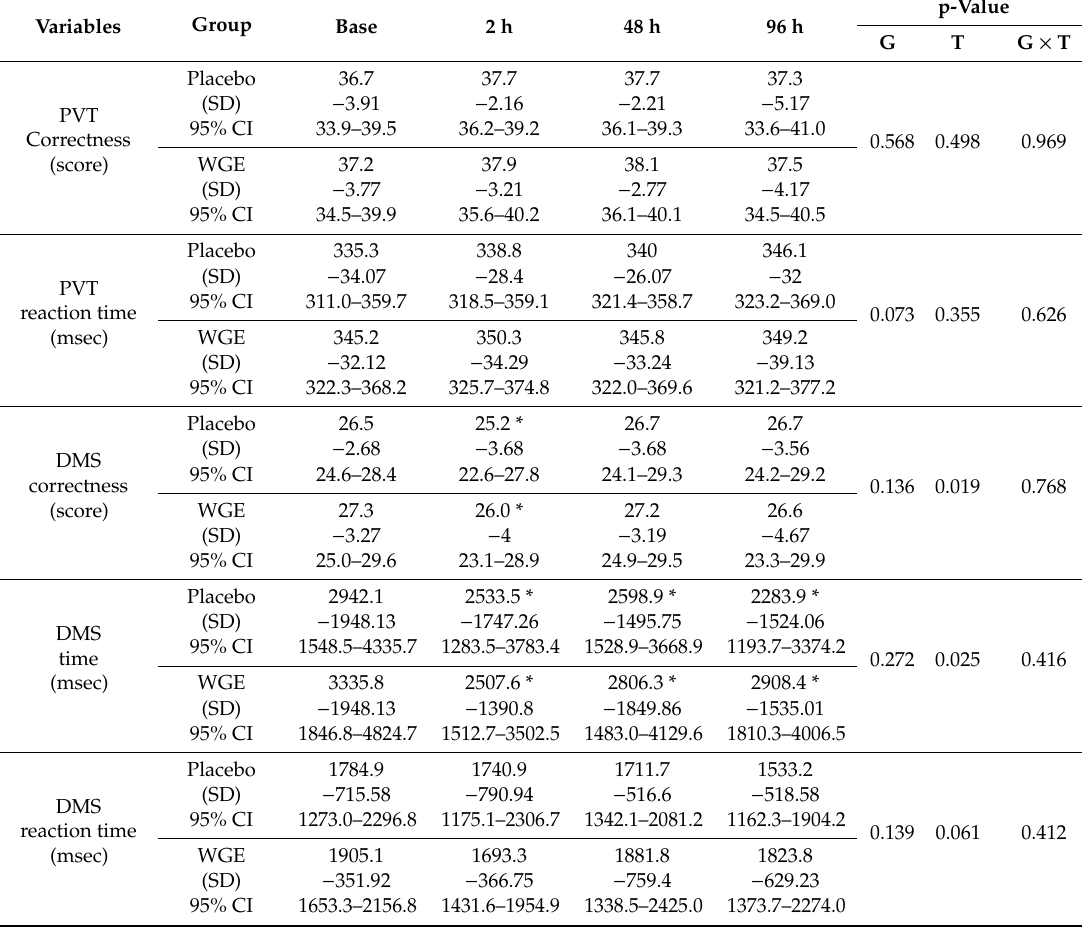
Table 3. The results of psychomotor performance following acute eccentric